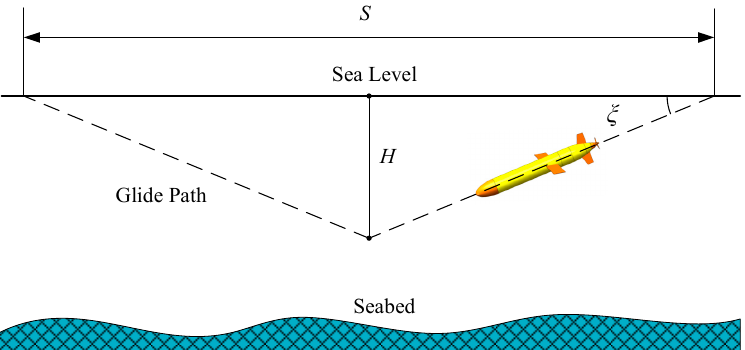
Figure 8. Schematic diagram of the profile motion.